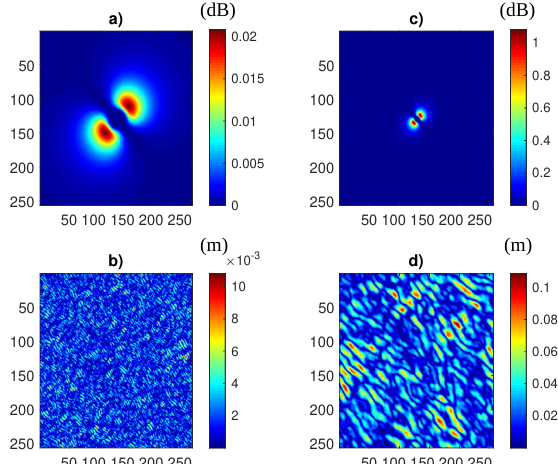
Figure 10. Elfouhaily spectrum ( a , c ) and sea surface ( b , d ) simulated with it for 5 m / s (left) and 10 m / s (right) wind speed oriented at 45 ◦ .